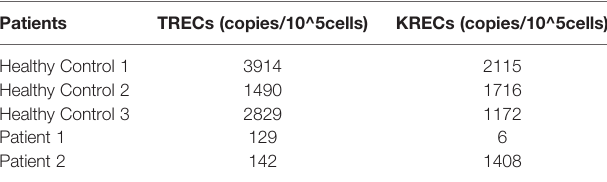
TABLE 3 | Quanti fi cation of TRECs and KRECs.